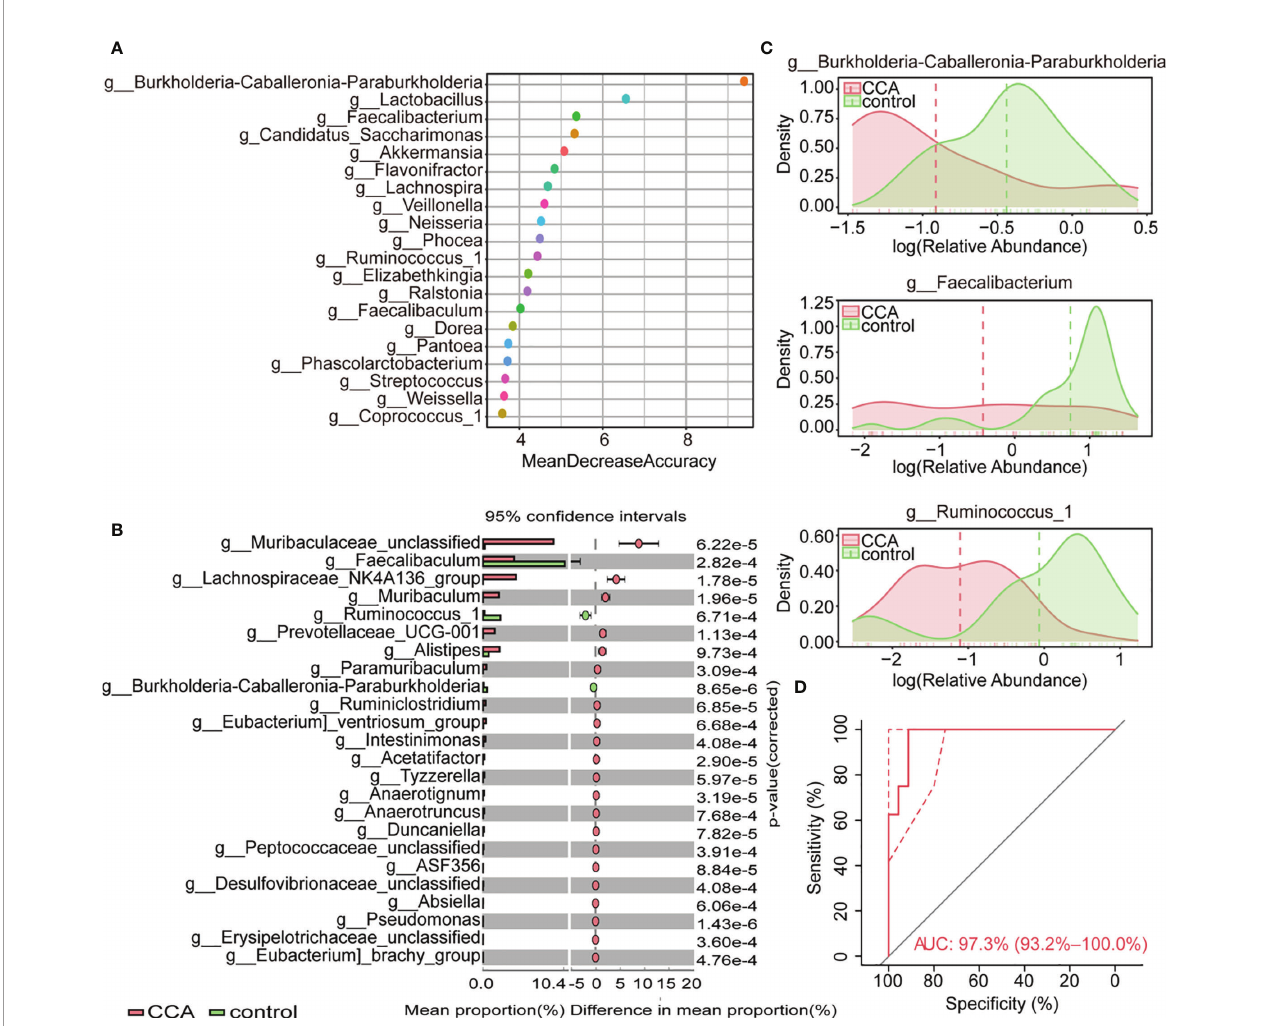
FIGURE 2 | Variations of fecal microbiota composition among cholangiocarcinoma (CCA; n = 53) and control (n = 40). (A) The top 20 most important genera for discriminating CCA from control were screened out by random forest (RF). Each genus is ranked according to mean decrease accuracy. (B) Relative abundances of top 24 differentially expressed genera were evaluated by the Statistical Analysis of Metagenomic Pro fi le (Eelch ’ s test, P < 0.001). The left and right panel demonstrated the average relative abundance and the 95% con fi dence interval of each genus in CCA and control, respectively. (C) Density curve of g_Burkholderia- Caballeronia-Paraburkholderia, g_Faecalibacterium, and g_Ruminococcus_1 (B-F-R) based on their relative abundances. (D) Classi fi cation effect of B-F-R genera model was assessed by receiver operating characteristic (ROC)